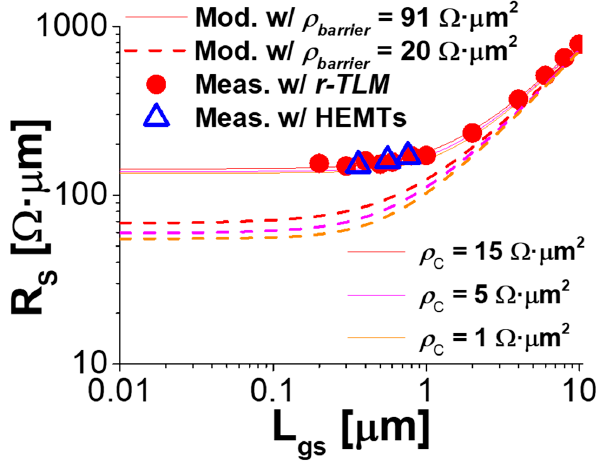
Figure 6. Comparison of the modeled and measured R S against L gs in the log-log scale.